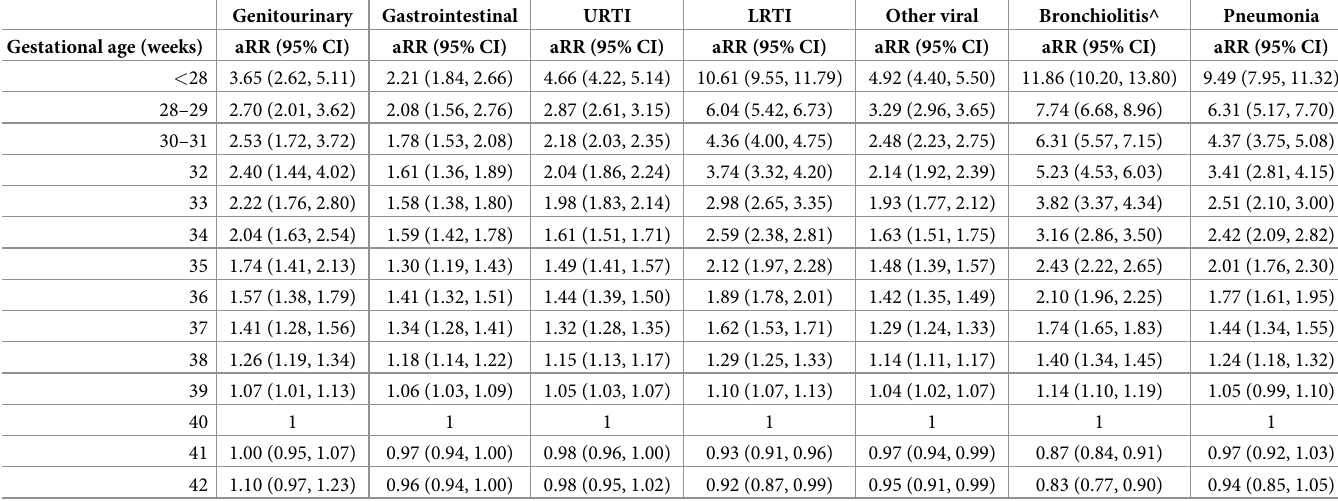
Table 4. Adjusted � rate ratios and 95% confidence intervals for gestational age at birth by type of infection, from birth to 10 years of age.